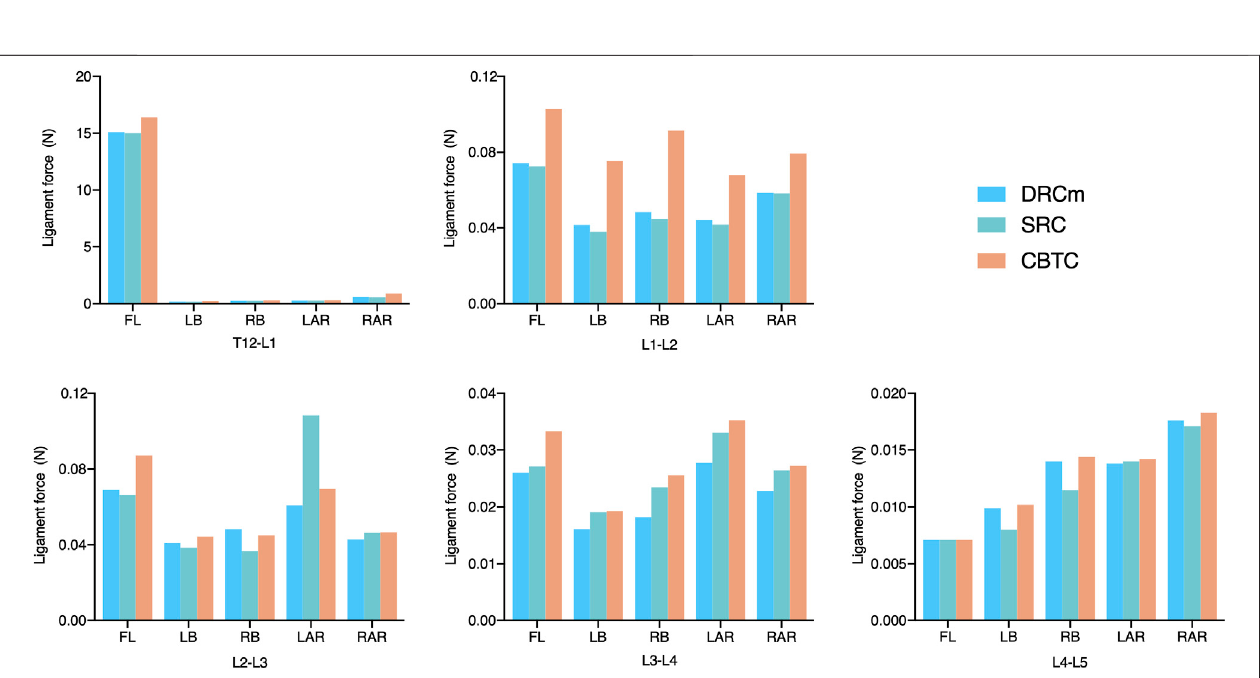
FIGURE 7 | Ligament force of the SSL in the loading direction of FL, LB, RB, LAR, and RAR after RS instrumentation using the DRCm, SRC, and CBTC.